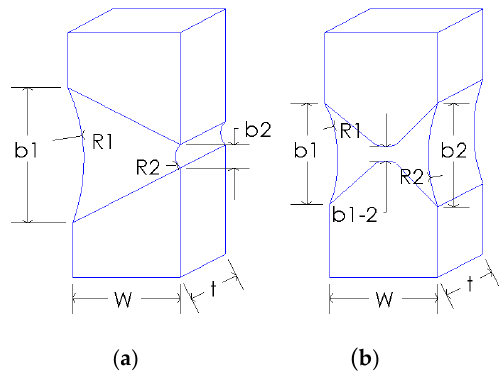
Figure 8. Characteristic dimensions of weld metals: ( a ) V shape, ( b ) X shape.